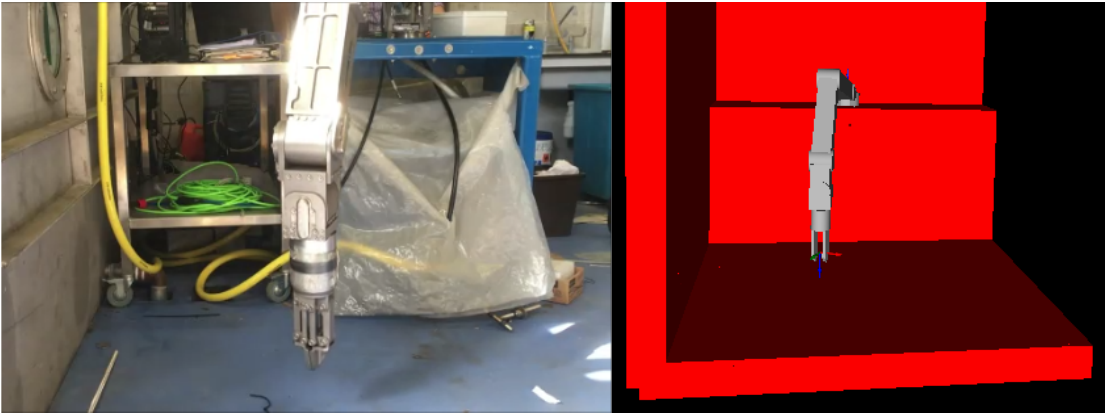
Figure 12. Experimental setup with the floor as an